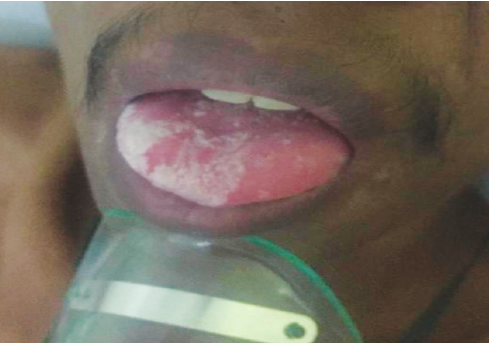
Fig. 1. Pseudomembrane in the patient’s tongue